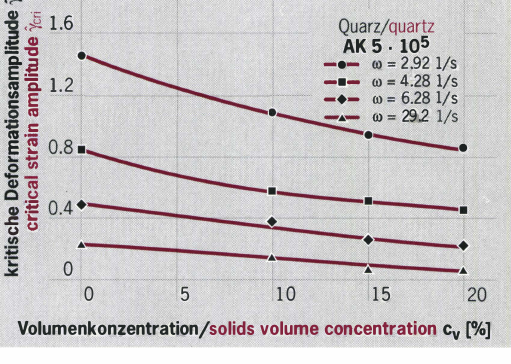
Fig. 7: Comparison of the critical strain amplitude of different suspensions with the